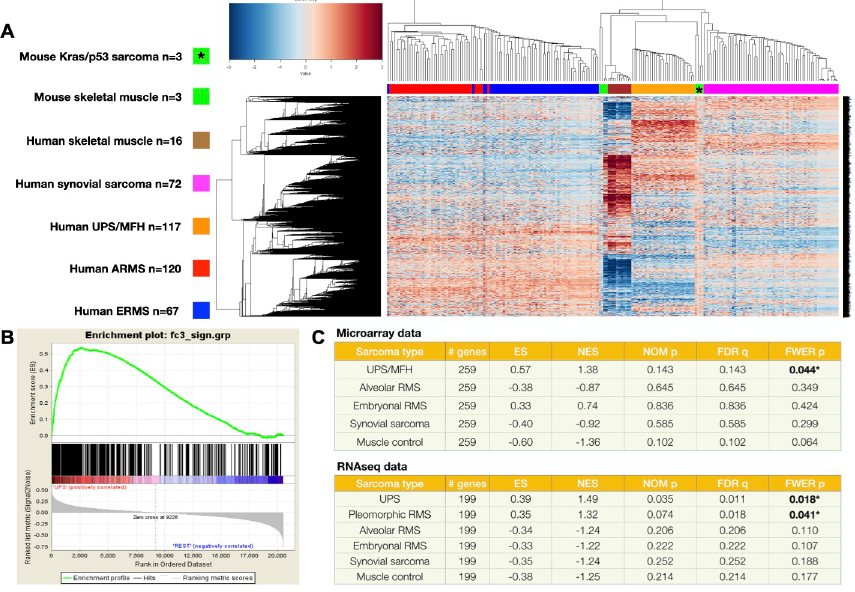
Fig 2. Transcriptomic analyses show murine sarcomas resemble human UPS. (A) Unsupervised hierarchical clustering of murine sarcoma RNAseq data with that of muscle lineage human soft tissue sarcoma shows murine sarcomas group with human UPS. (B-C) Additional gene set enrichment analyses the top differentially expressed genes of spontaneous murine tumours sarcomas is most similar to human UPS.